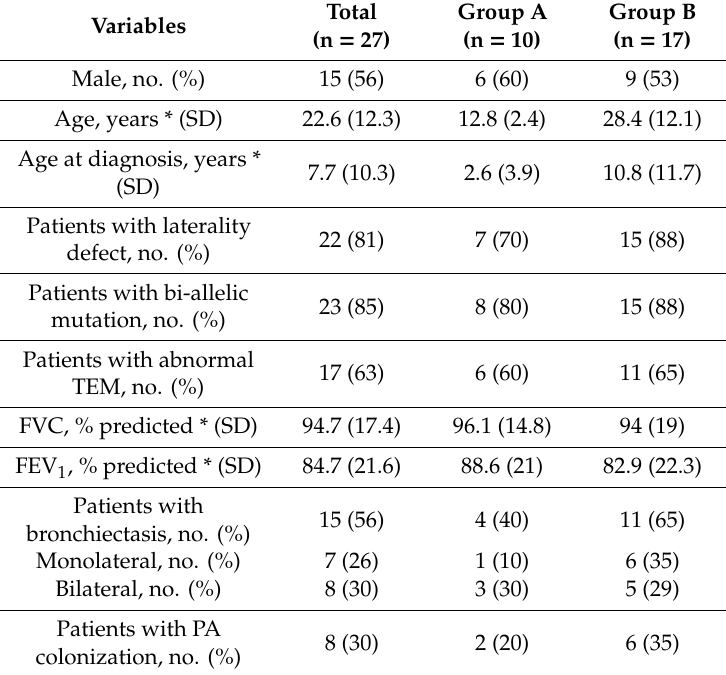
Table 1. Demographic and clinical characteristics of patients with primary ciliary dyskinesia. Total Variables (n =